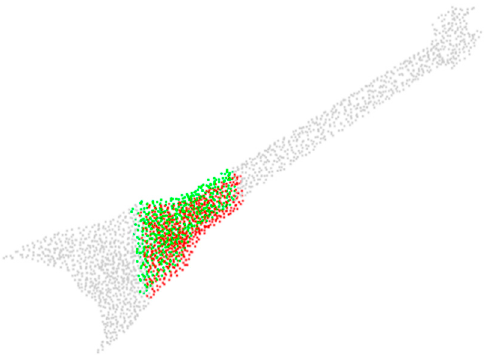
Figure 13. Initial point cloud stitching when the target tracking system has errors. In the source point cloud ( P ), there are some points near the part with the same shape, and the spacing between these points and the nearest points in the target point cloud ( Q ) is smaller than the threshold ( δ ), so the two parts with the same shape of the two-point clouds calculated based on the stitching results of the target tracking system are not exactly the same. As shown in Figure 14, the red and green points are the parts with the same shape in the source point cloud ( P ) and the target point cloud ( Q ), respectively, and the blue points are points that do not have the same shape according to the stitching results of the target tracking system. Therefore, it is proposed to correct the initial point cloud stitching by combining the global and local information features of the point cloud to form accurate information related to the point cloud stitching.